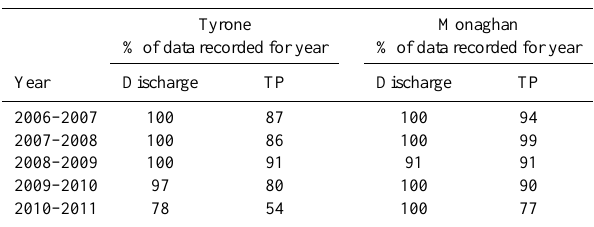
Table 3. Completeness of discharge and TP data for both catch- ments from